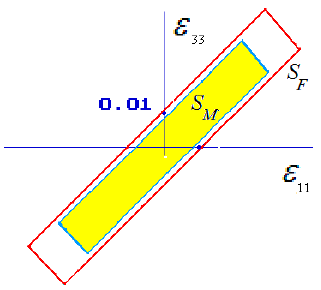
Figure 3. Failure surface for matrix and for fiber for the axial tension modes .